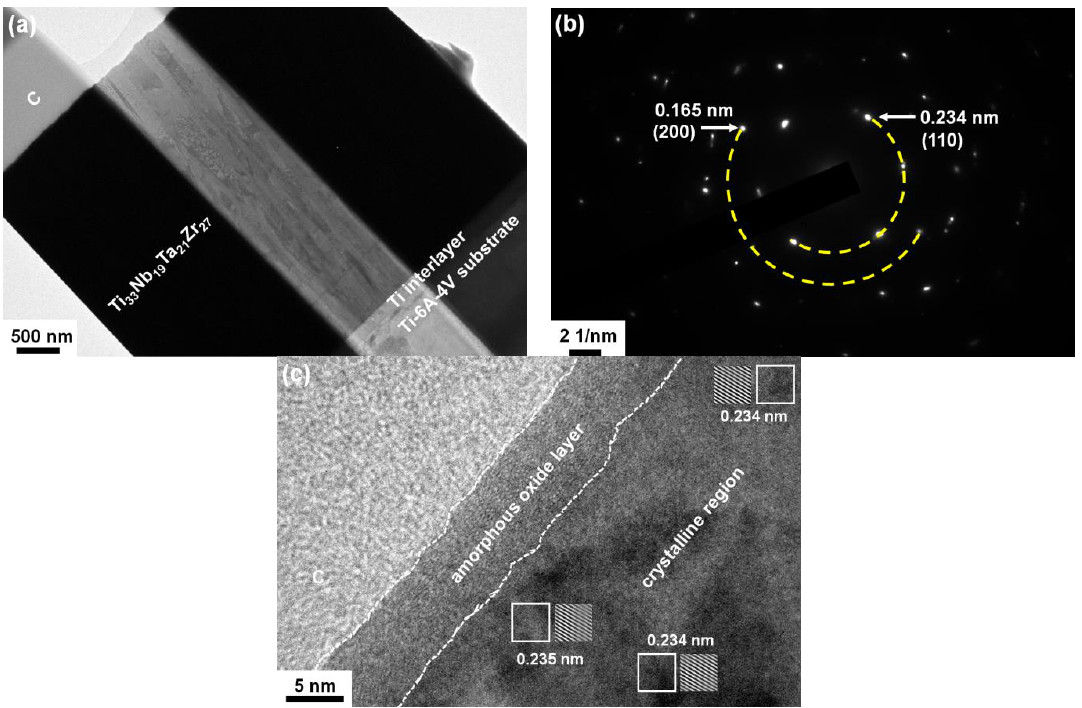
Figure 6. ( a ) XTEM image, ( b ) SAED pattern, and ( c ) HRTEM image of the Ti 33 Nb 19 Ta 21 Zr 27 film after immersion in Ringer’s solution for eight weeks .